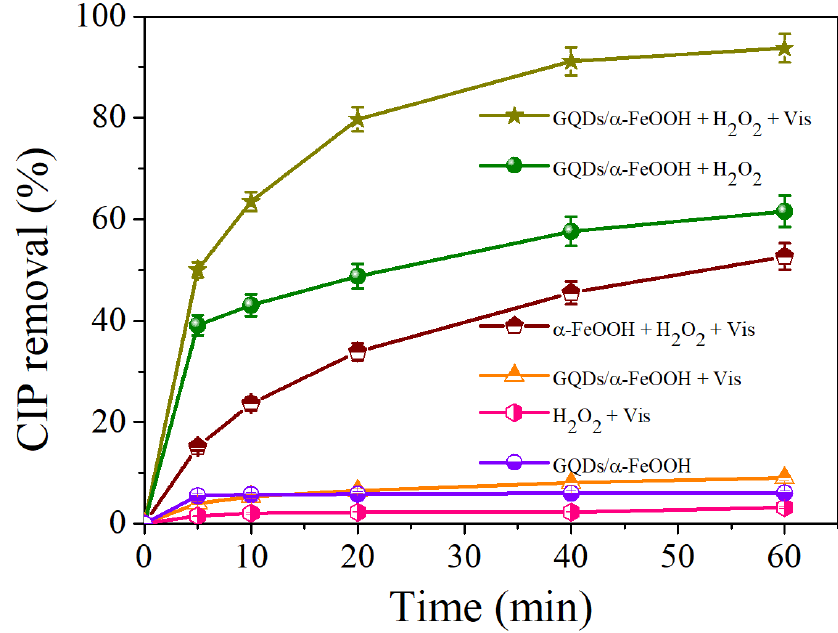
Figure 2. Degradation of CIP under different experimental conditions.